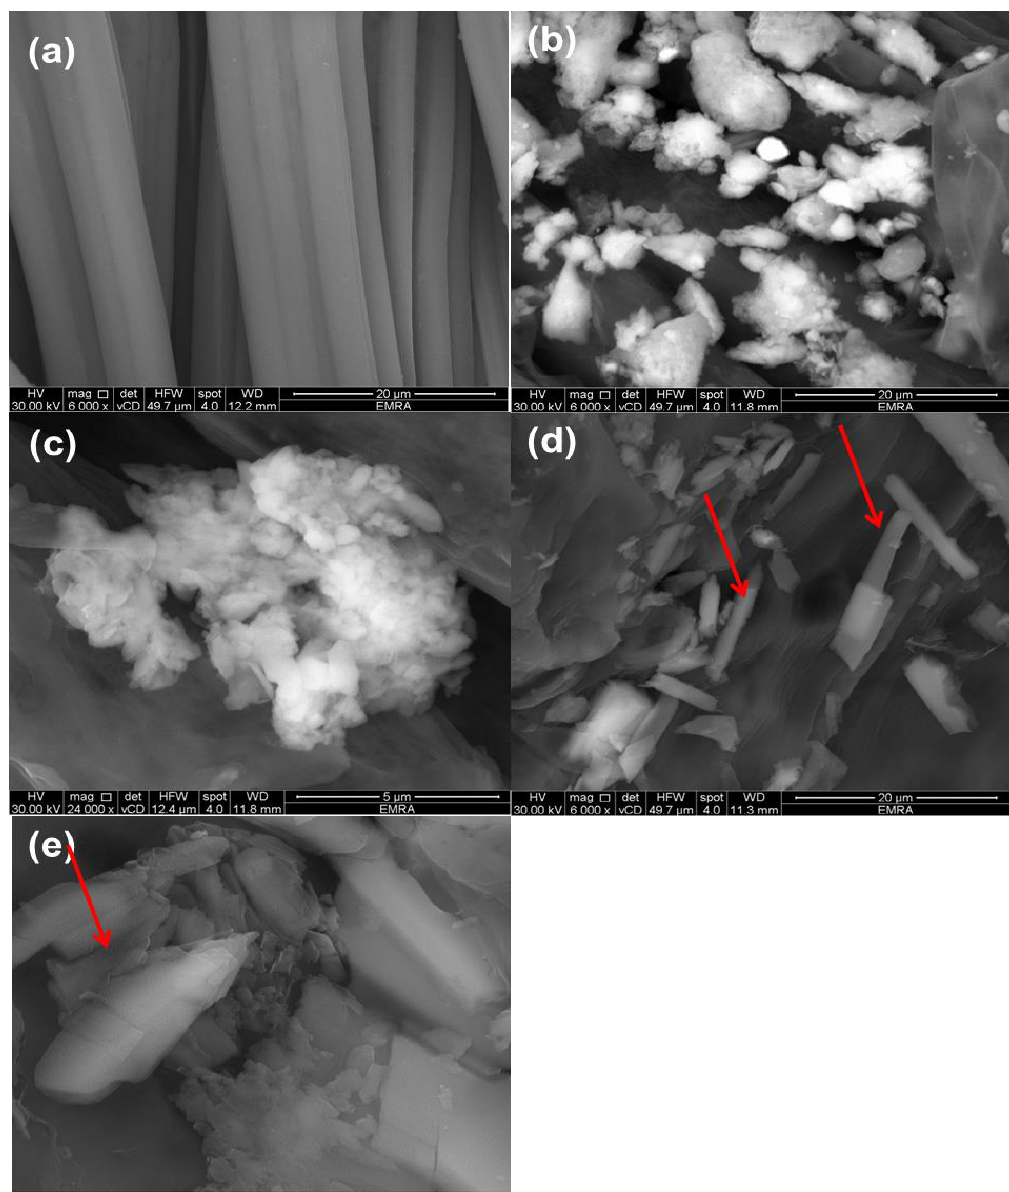
Figure 2. SEM images of ( a ) Blank Textile (T), ( b ) Textile coated with chitosan (T–CH), ( c ) T–CH at high magnification, ( d ) Textile coated with chitosan and organic agent 50 wt.% (CH–T–OA–50), and ( e ) CH–T–OA–50 at high magnification.